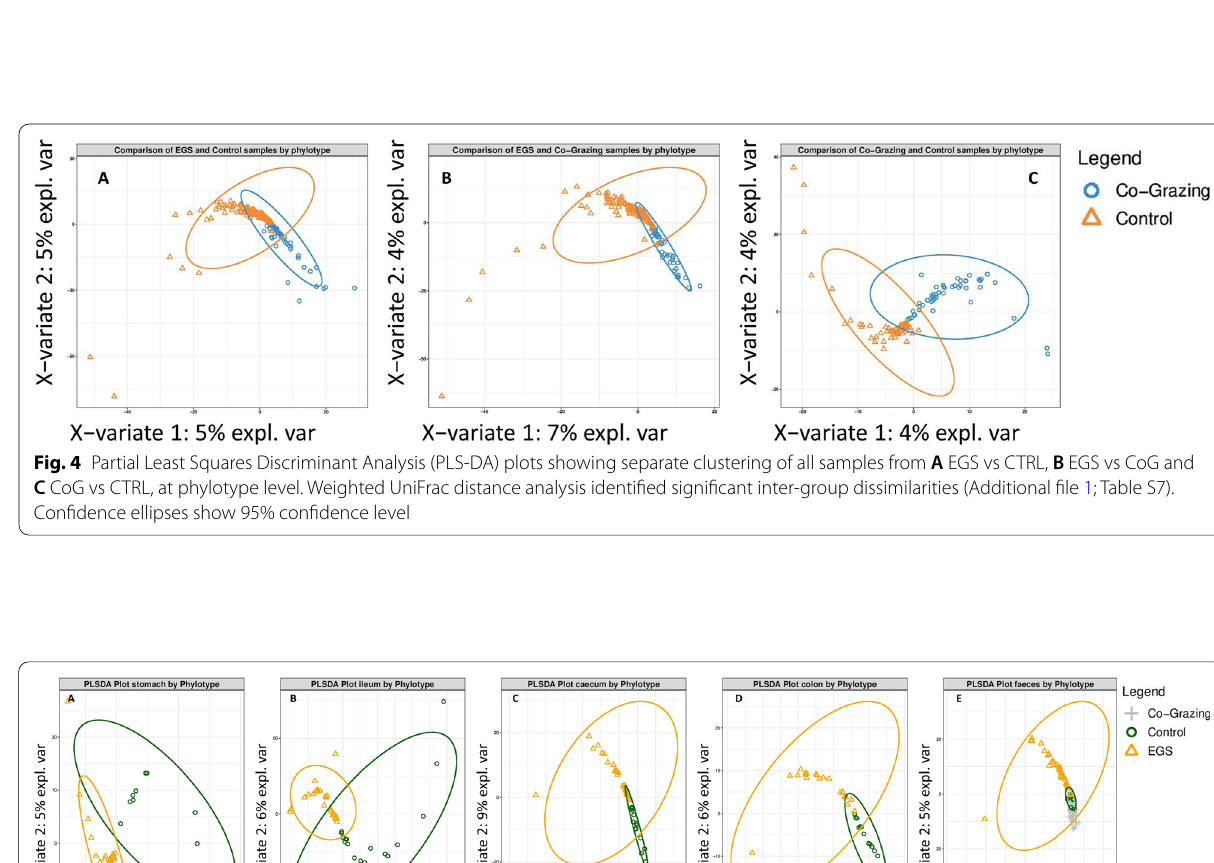
Fig. 3 PLS-DA plots showing clustering of samples by GI site in A EGS and B CTRL groups, at phylotype level. Confidence ellipses show 95% confidence level. For statistical analysis, see Additional file 1; Table S6